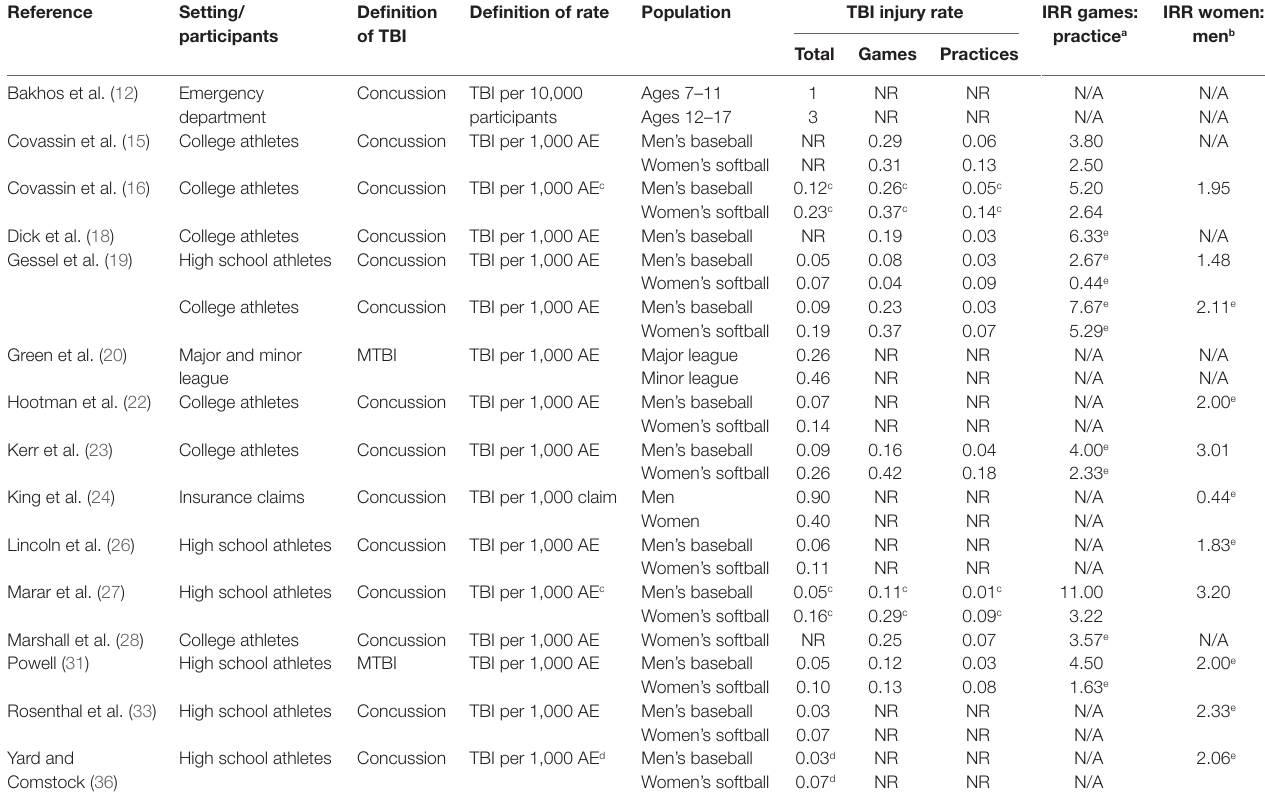
taBLe 4 | Rates of baseball-and softball-related